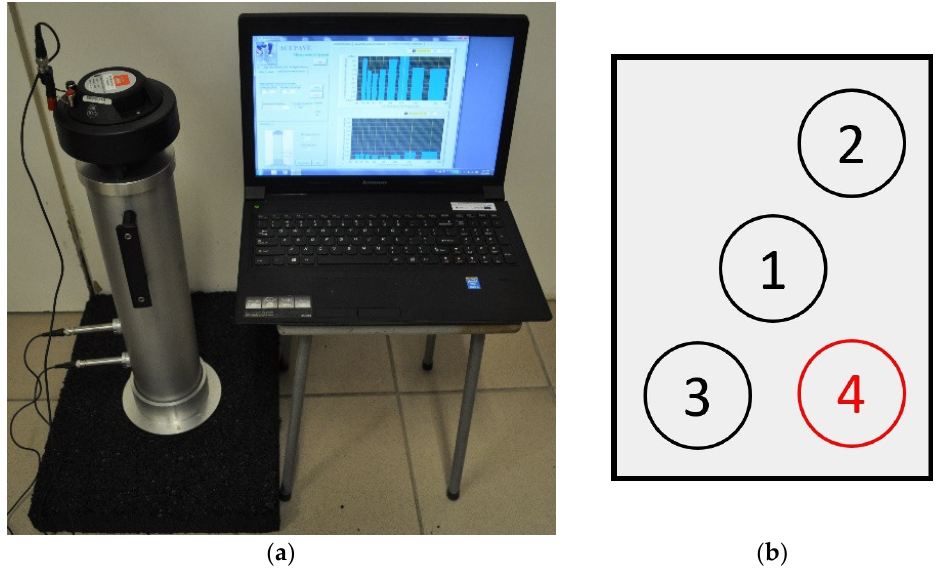
Figure 3. Sound absorption coefficient measurement on a test slab ( a ) and locations of measurements and coring of cylindrical specimens ( b ).